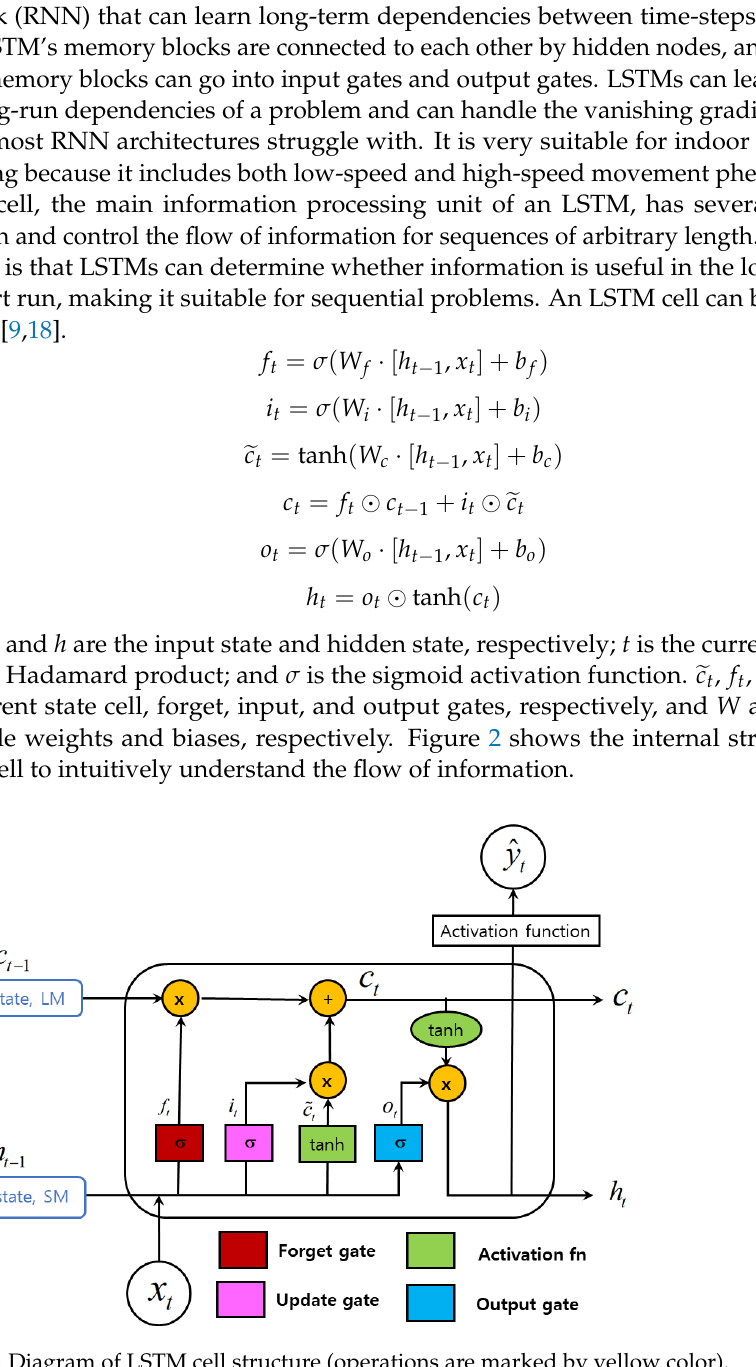
Figure 2. Diagram of LSTM cell structure (operations are marked by yellow